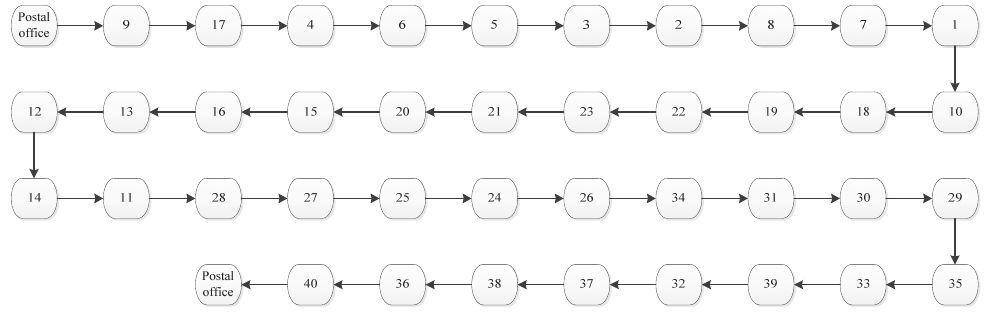
Fig 6. The optimum route for servicing customers